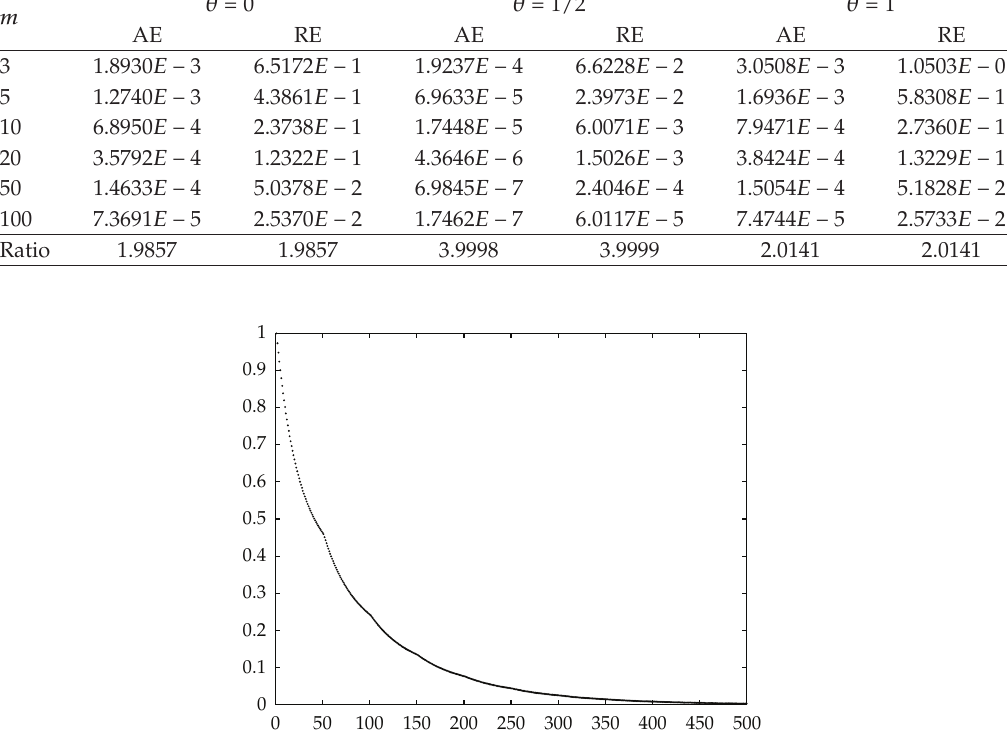
Figure 1: Linear θ -method with θ (cid:6) 0 for (cid:4) 5.1 (cid:5)